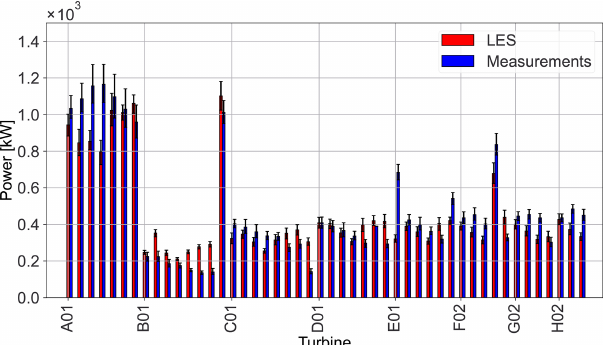
Figure 12. Bar plot of turbine power production for the case PDk 1 . Error bars represent 95% confidence intervals on the mean and are computed using the block–bootstrap method and time windows of 600s and 1000 bootstrap